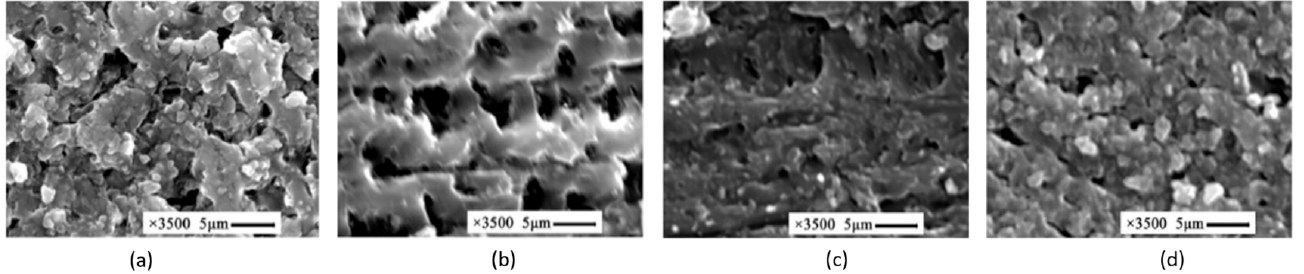
Figure 22. Organically modified silicates (OLS) sensitivity of epoxy-based electrolytes microstructure from Yu et al. [81]. ( a ) 0% OLS. ( b ) 2.5% OLS. ( c ) 5.0% OLS. ( d ) 7.5% OLS.